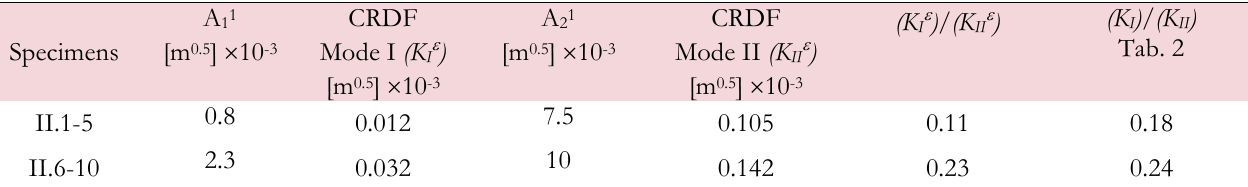
Table 4: Compact Shear Test– Crack Relative Displacement Factor